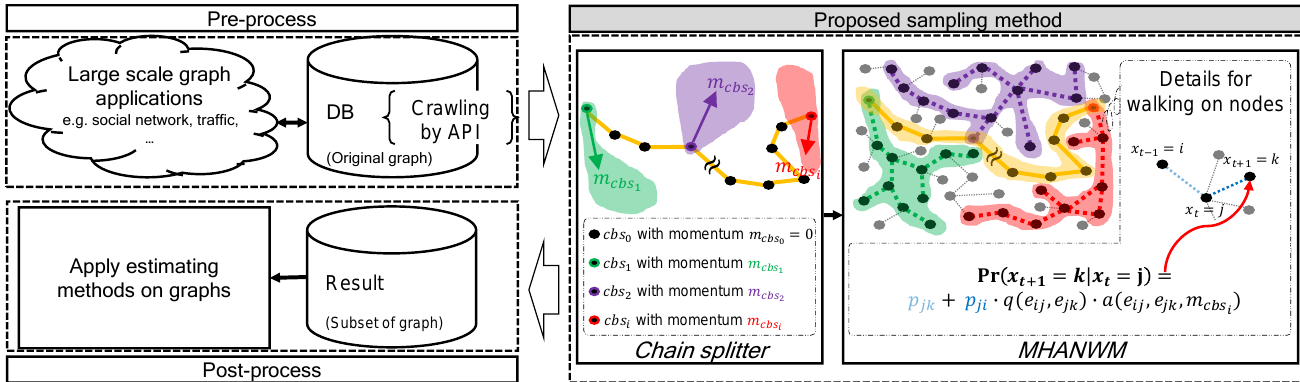
Figure 2. Overview of proposed method (best viewed in